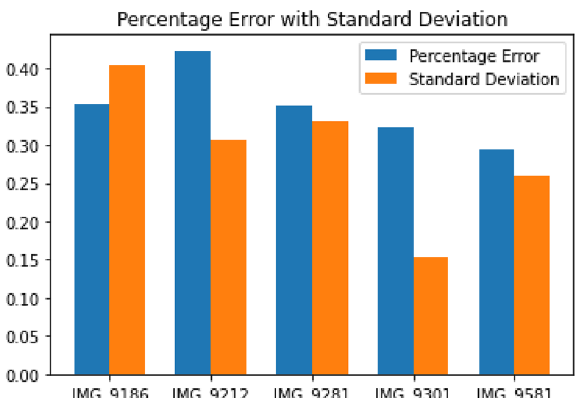
Table 1. A table showing bounding box areas of 10 randomly selected dump particles of IMG_9281 from ground truth data and predicted masks of validation dataset